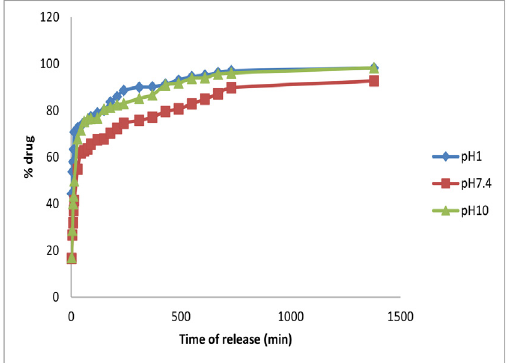
Fig.5. In vitro release profiles of A in different pHs.